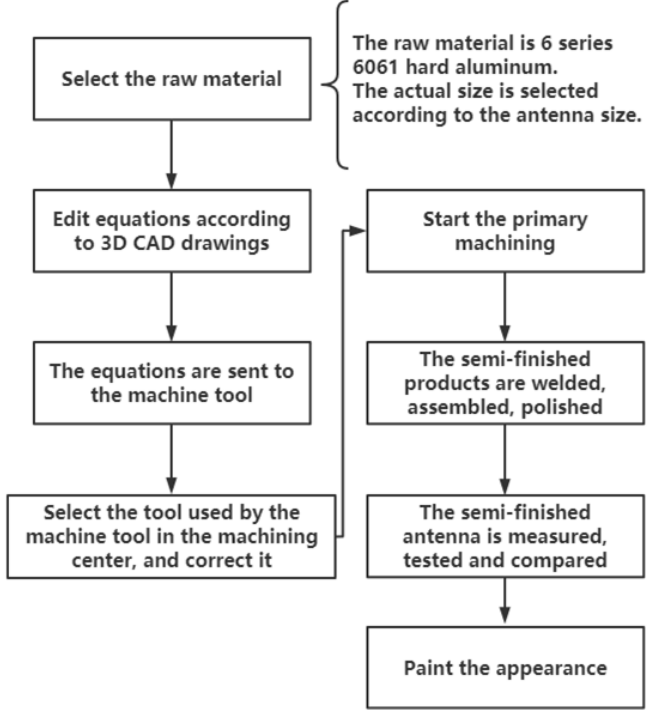
Figure 5. Antenna processing flow chart.